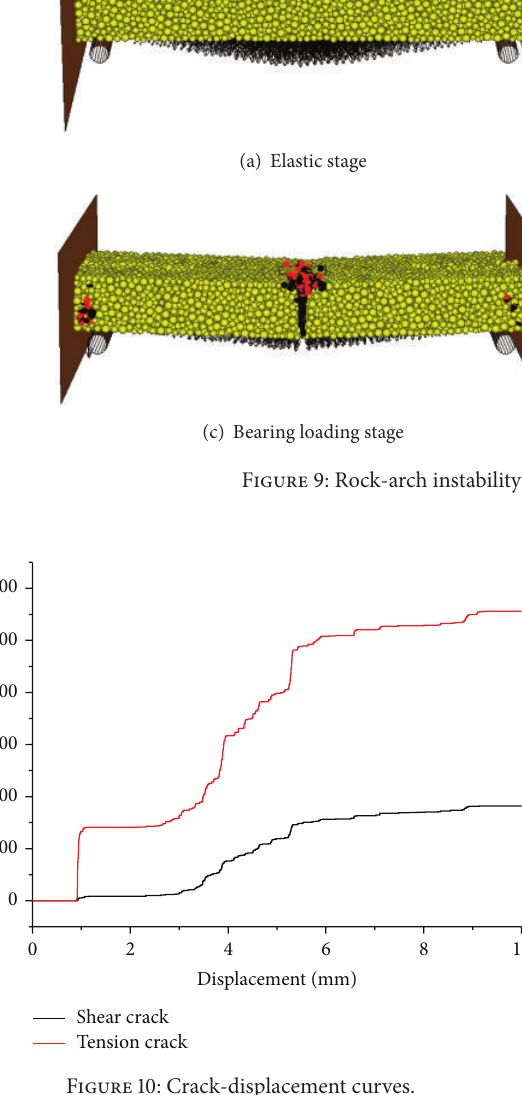
Figure 10: Crack-displacement curves.